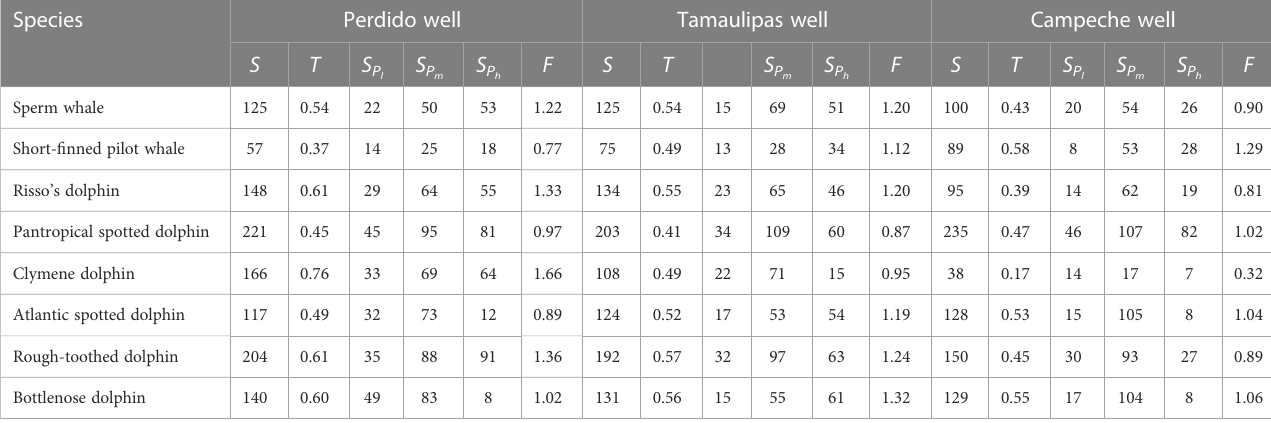
TABLE 5 Values of the parameters to estimate the feasibility of exposure to oil ( F ) of eight odontocetes from the Gulf of Mexico under three oil spill scenarios. Species Perdido